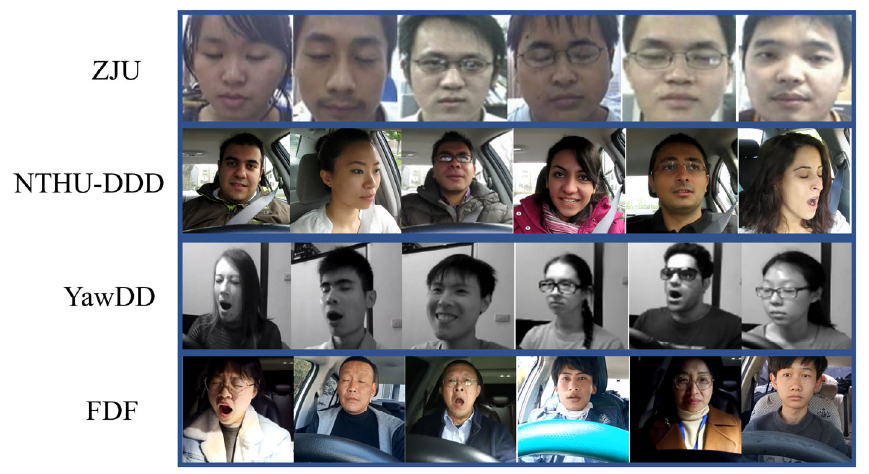
Figure 7. Some samples of the fatigue driving dataset.